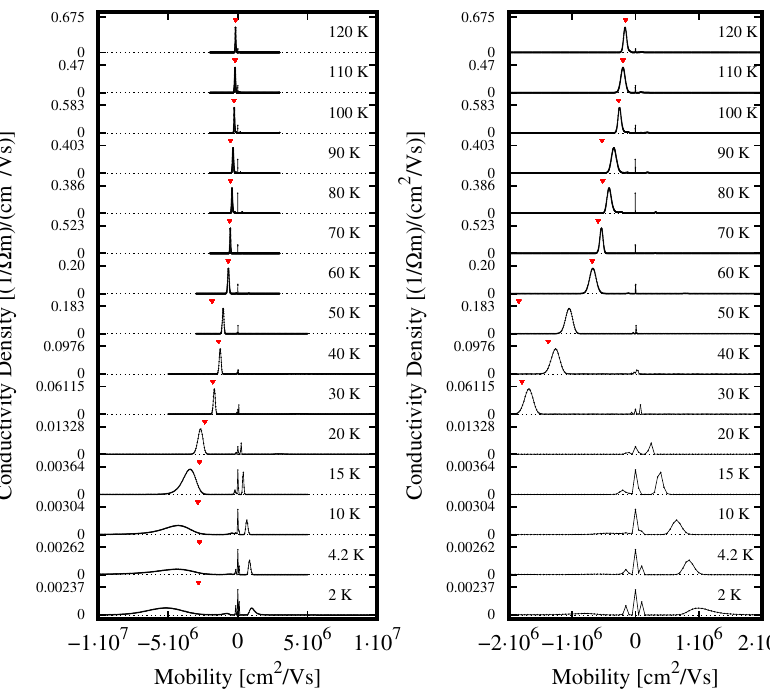
Figure 5. Evolution of the mobility spectrum as a function of temperature. Negative mobility corresponds to electrons, positive mobility to holes. The right panel shows an enlarged zero-centered part of the left panel. The spectra are shifted vertically for better presentation. Downward triangles mark results of fit of Equation (1) with N =